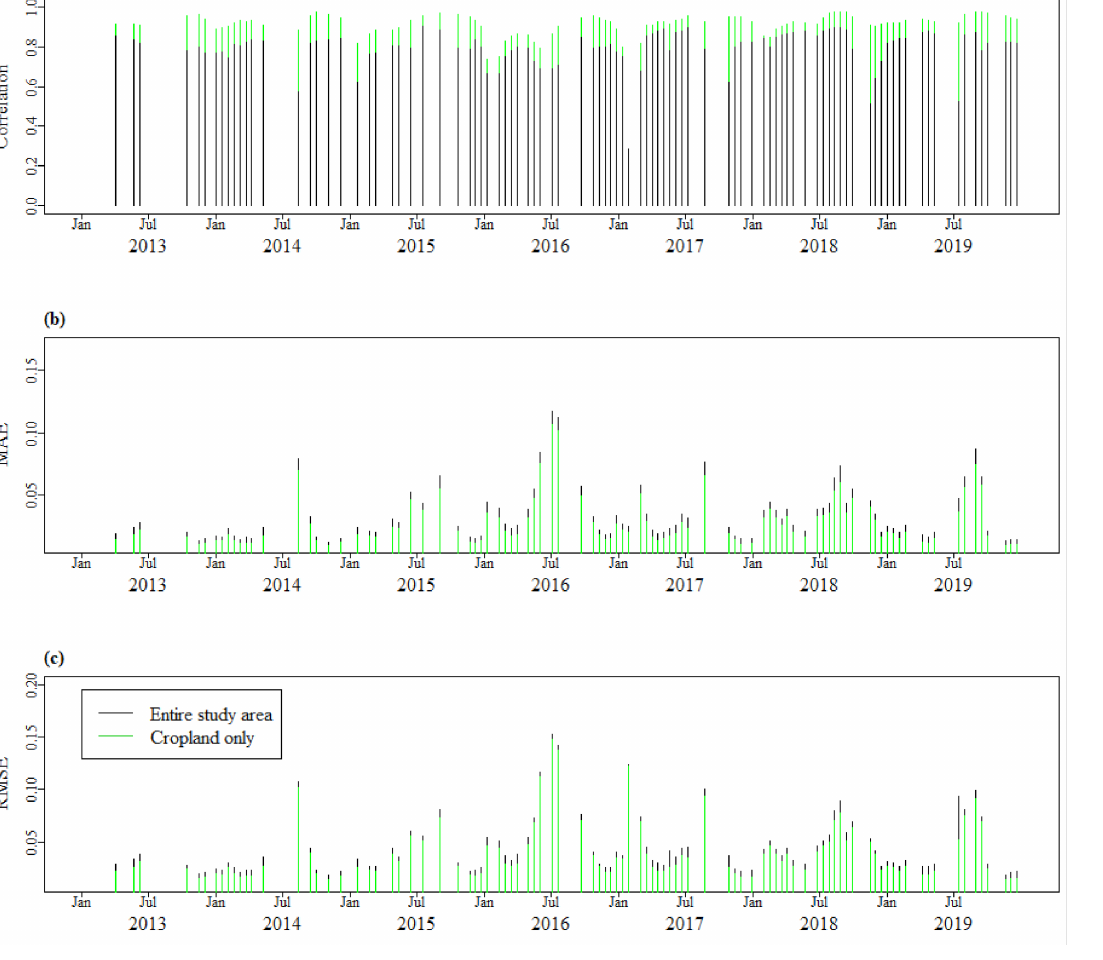
Figure 8. Per-image accuracy for the Landsat-8 test data for the entire train/test area (black) and cropland only (green): ( a ) correlation; ( b ) MAE and ( c )